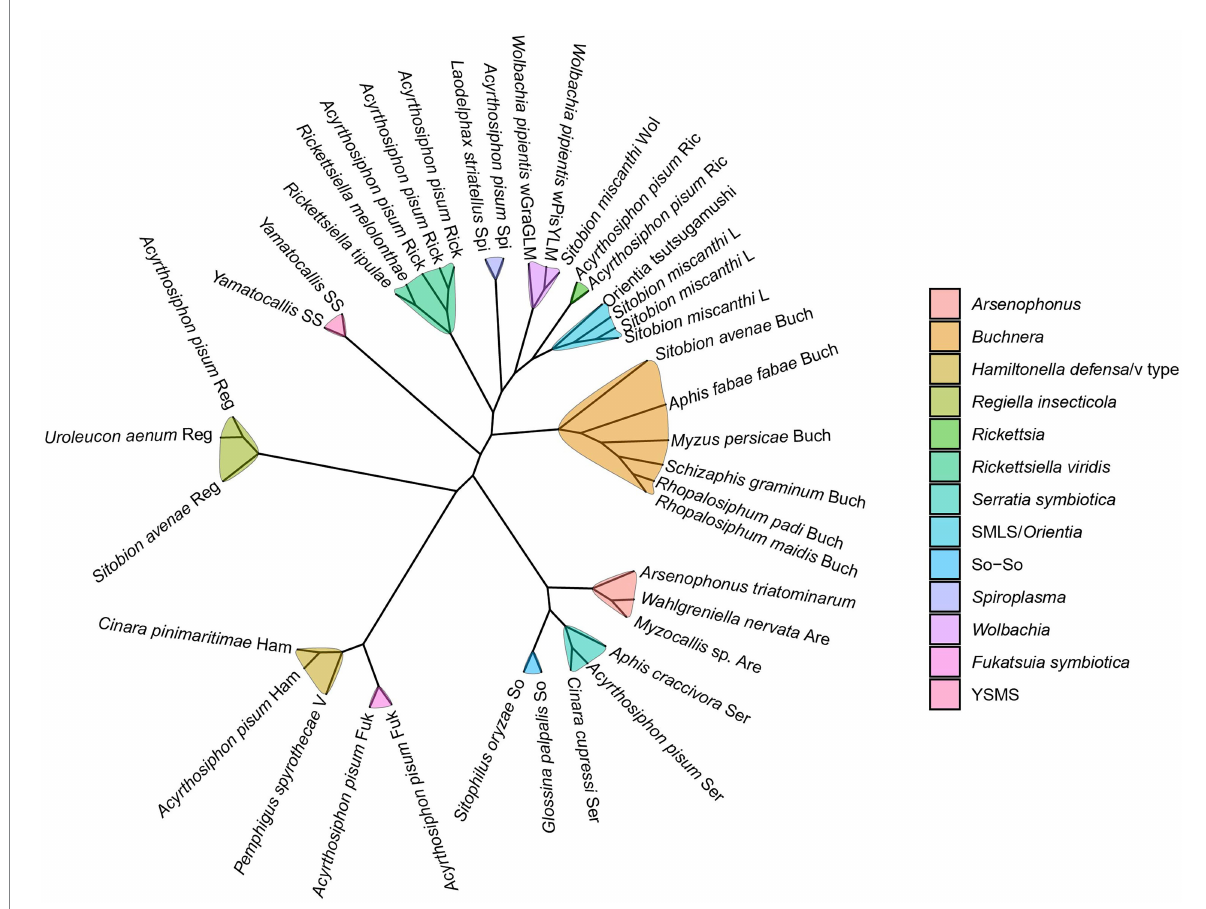
FIGURE 1 The cladogram of the aphid facultative symbionts. This cladogram is visualized by the ggtree R package (Yu et al., 2017). The information of the sequences used here is provided in the supplementary Supplementary Table